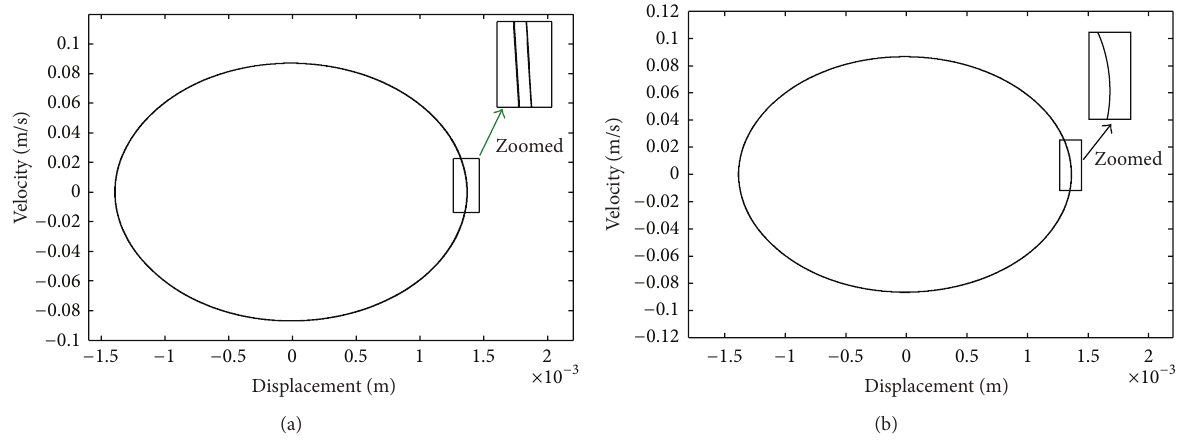
Figure 12: Phase orbits at different excitation frequencies: (a) 9.98 Hz and (b) 10.00